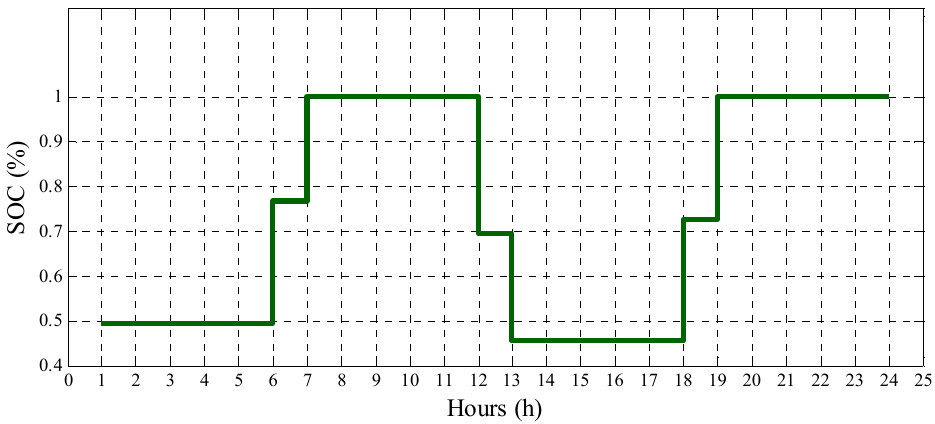
Figure 4. Energy level of battery electric vehicle type 1 in Scenario 4.